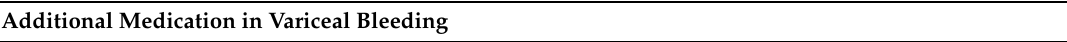
Table 3. Additional medication in variceal bleeding.